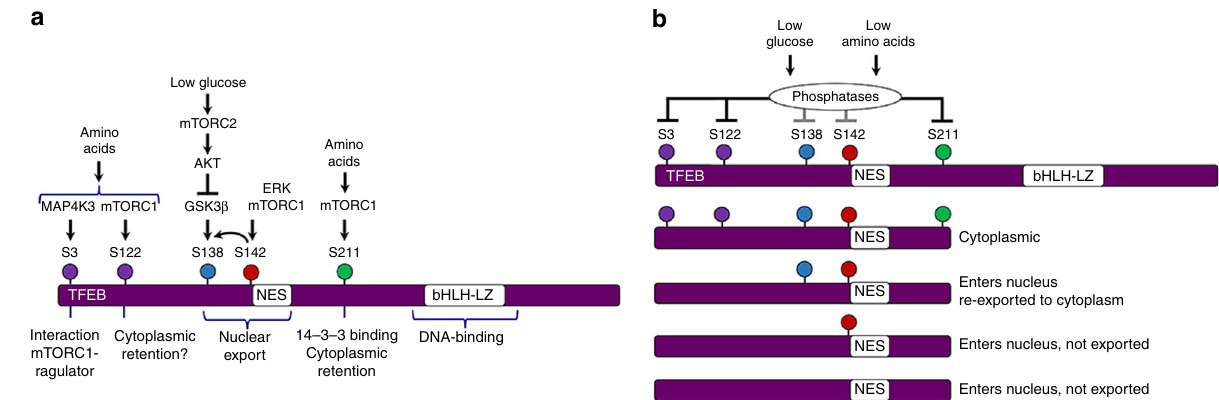
Fig. 8 Model to explain regulation of TFEB subcellular localization. a Summary of key regulatory phosphorylation events and their impact on TFEB subcellular location. b Model to explain the potential regulation of TFEB when amino acids or glucose are limiting. Under these conditions increased phosphatase activity targeting S211, and likely other phosphorylation sites, will release TFEB from its cytoplasmic anchor. Whether TFEB is retained in the nucleus will be dependent on the phosphorylation status of S138 and S142. Absence of phosphorylation of S138 or S142 will lead to nuclear retention. Note however that in this model dephosphorylation of S142 or S138 is not a necessary pre-requisite for nuclear